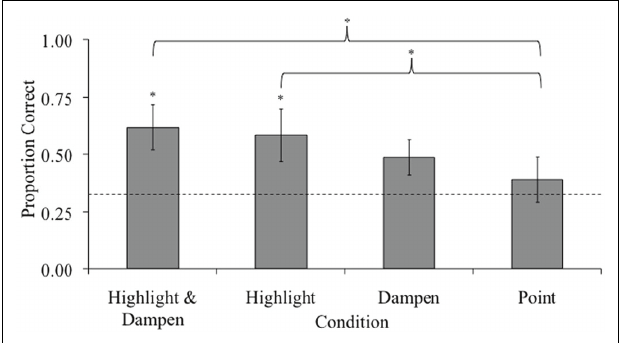
FIGURE 3 | Children’s proportion of correct choices during the retention task. Dotted line represents chance (0.33). Error bars represent 1 SE. * p <